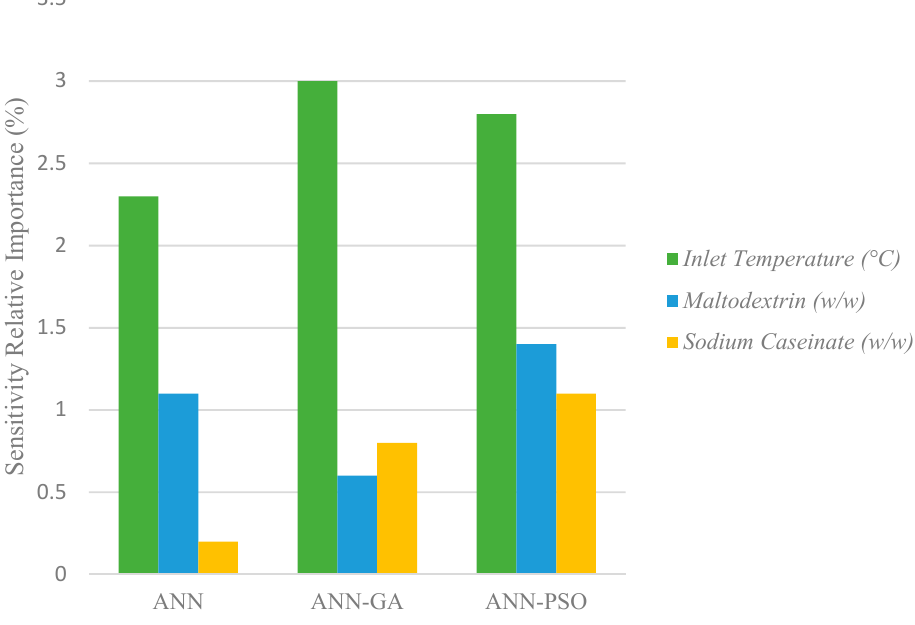
Figure 7. Sensitivity analysis of input variables.